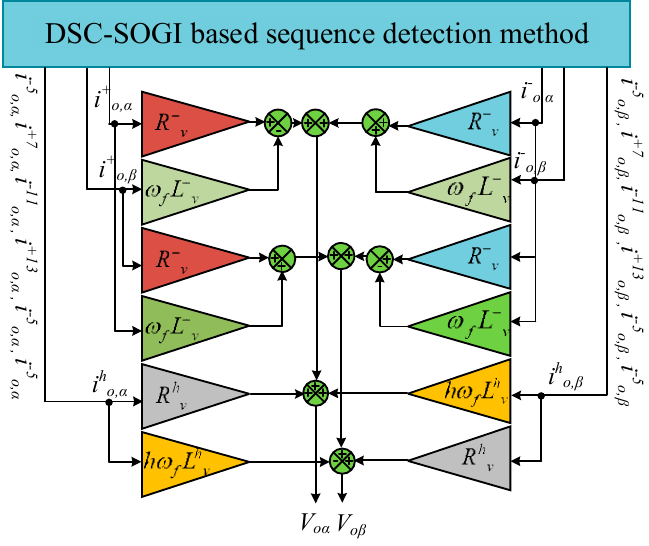
Figure 3. DSC-SOGI virtual impedance.